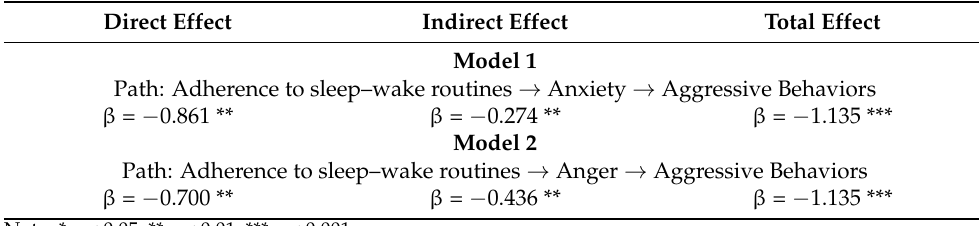
Table 5. Results of mediation Models 1 and Model 2.